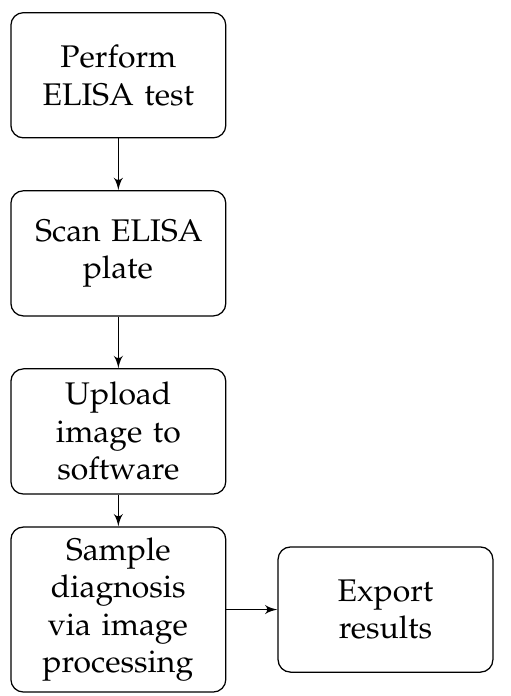
Figure 1. Schematic diagram of the proposed methodology.